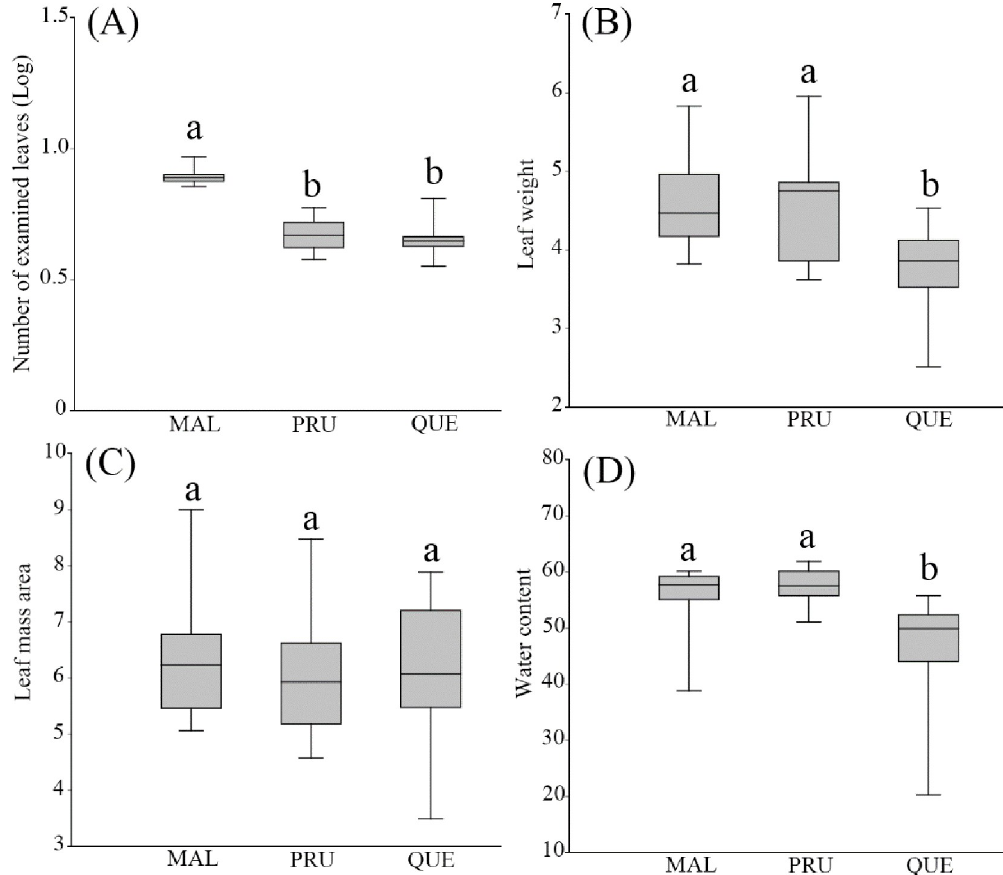
Fig 2. Box plot of the number of examined leaves (A), the fresh leaf weight (B), LMA (leaf mass per area) (C), and water content (D) for the three plant species across 18 islands . Different alphabet above the bar indicates the significant difference at P < 0.05.